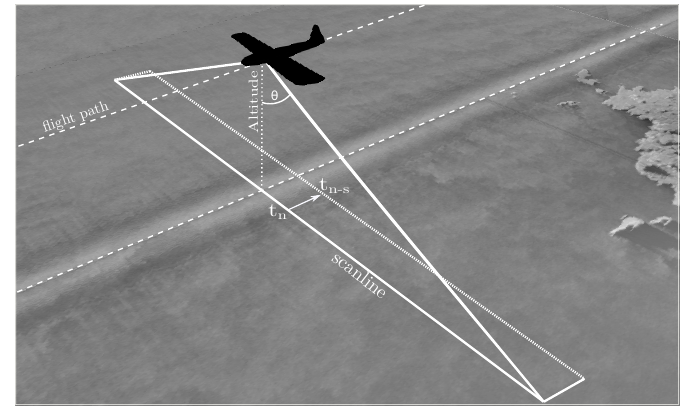
Figure 1. Scheme of the aircraft data acquisition system during